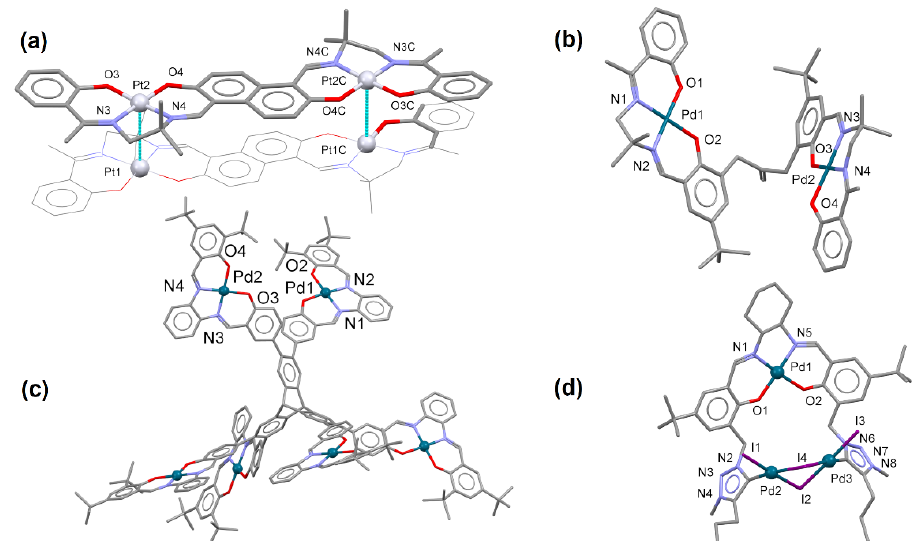
Figure 11. ( a ) Platinum(II) complex based on fused N 2 O 2 Schiff base ligand and metallophilic interactions [41]. (CSD Refcode GEDBEZ); ( b ) binuclear coordination compound of palladium exhibiting mechanochromic photoluminescent properties [42] (CSD Refcode UMAWUC); ( c ) hexanuclear palladium triptycene based hexakis(metalsalphen) coordination compound [173] (CSD Refcode MIRSEO) and ( d ) trinuclear salen − mesoionic N-heterocyclic carbene hybrid complex of Pd(II) one of thesymmetricallyindependentmolecules[174](CSDRefcodeSELCIY).Solventmoleculesandhydrogen atoms were omitted for